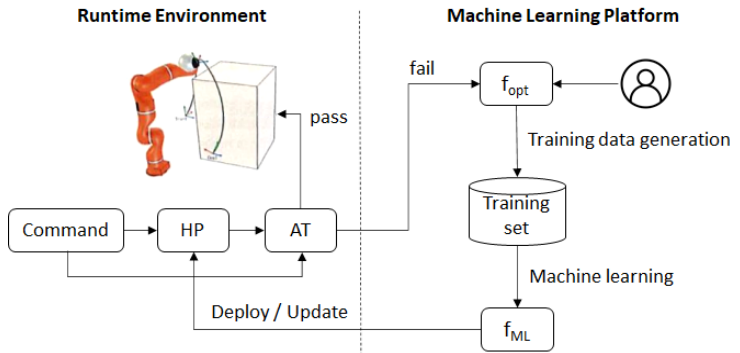
Figure 3. ML model training and runtime adaptation of the HP planner. f opt : an optimal computa- tional motion planning algorithm, f ML : the procedure by which a ML model is first trained, and AT: acceptance test.